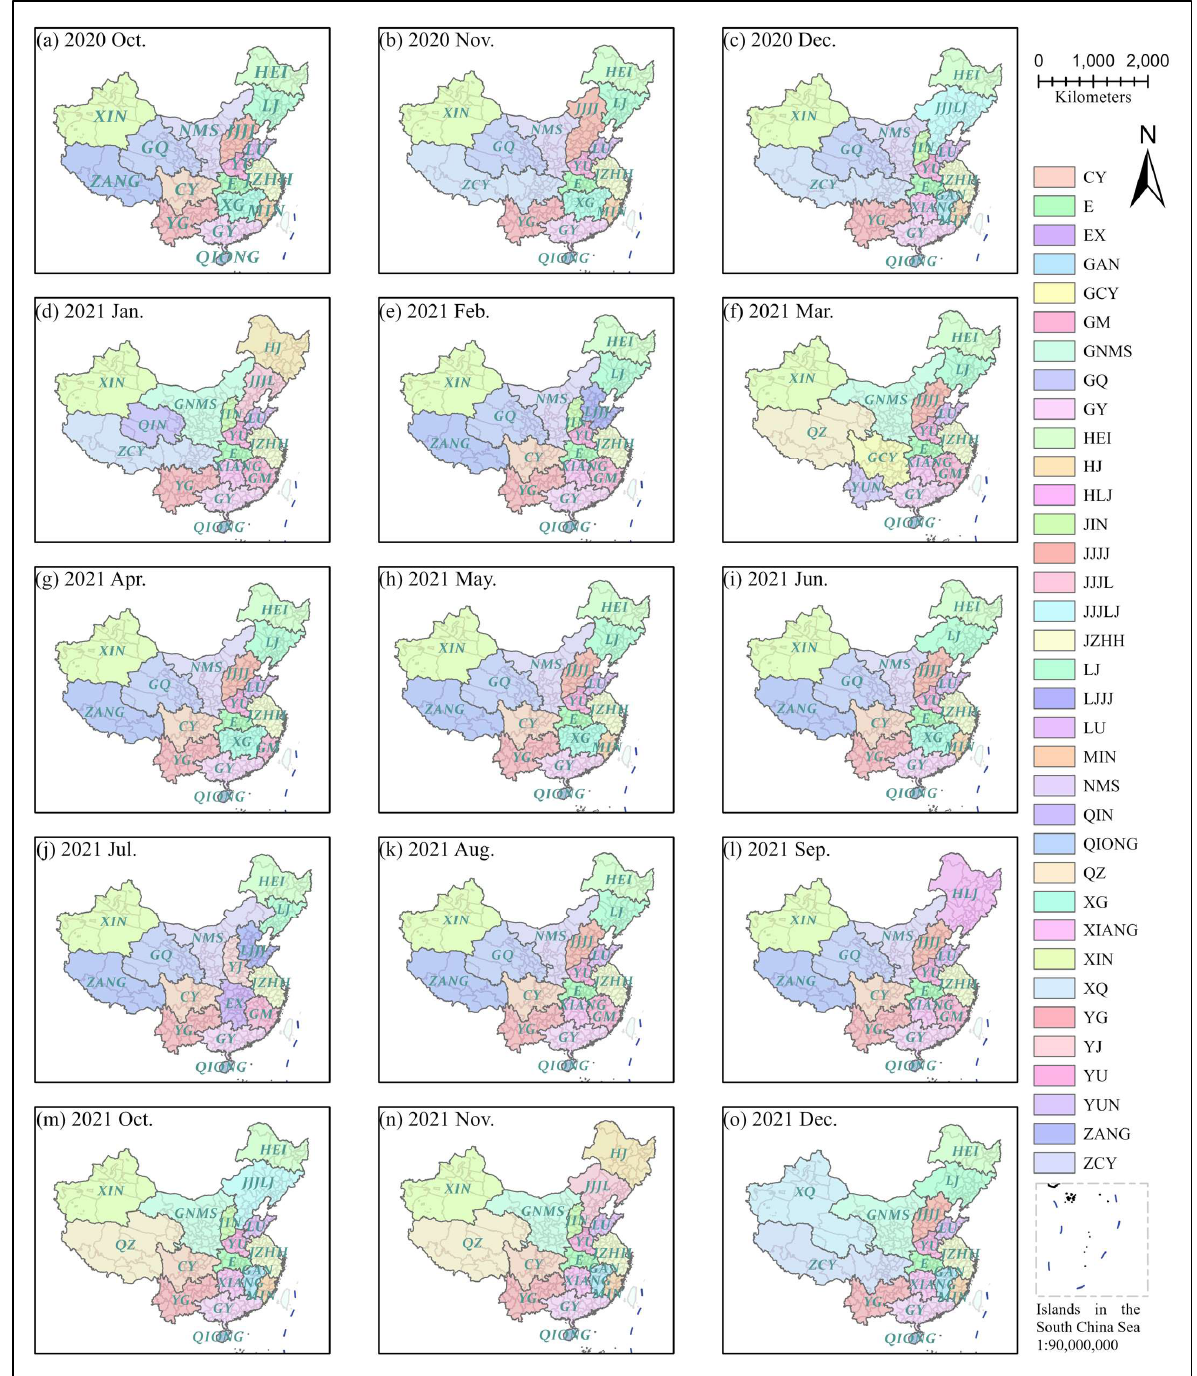
Figure 4. The urban communities of each month. Each sub-plot represents the information of the urban communities in that